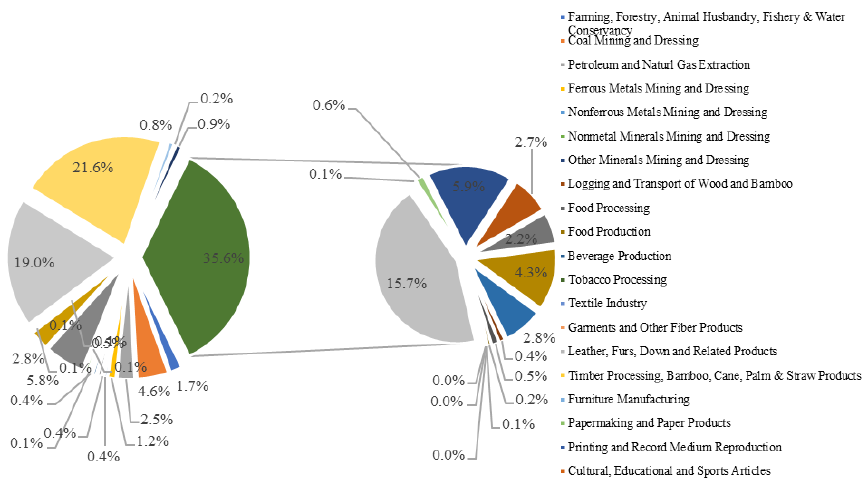
Figure 2. The proportion of carbon dioxide emissions in the industrial sector (Smelting and Pressing of Ferrous Metals, Nonmetal Mineral Products, Electric Supply, 21.6%, 19.0%, 15.7%). Energies 2019 , 12 , x FOR PEER REVIEW